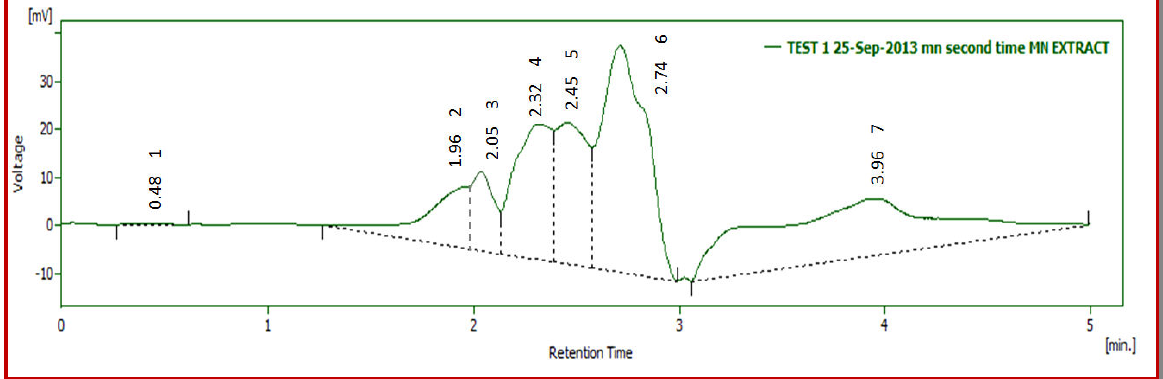
Figure 3: HPLC Chromatogram of aqueous methanolic extract of Morus nigra showing presence of quercetin, luteolin and isorham-